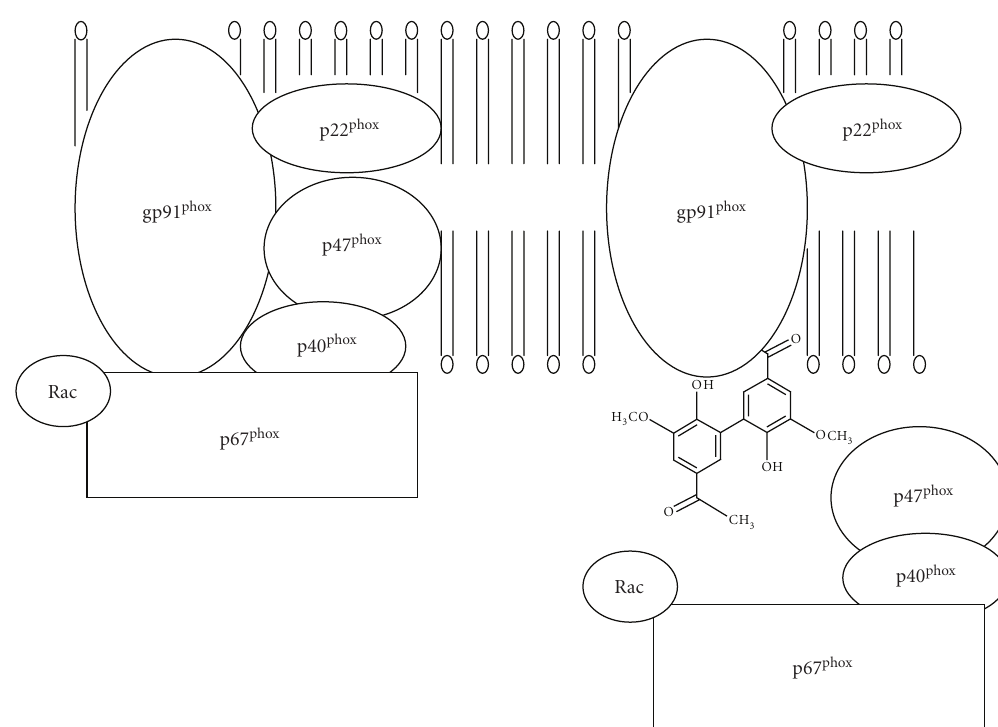
Figure 2: The mechanism of NADPH-oxidase inhibition by